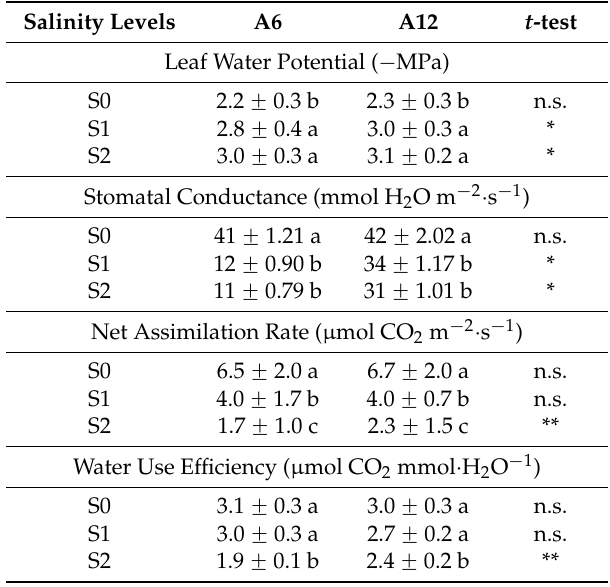
Table 5. Leaf water potential ( ´ MPa), stomatal conductance (mmol H 2 O m ´ 2 ¨ s ´ 1 ), net